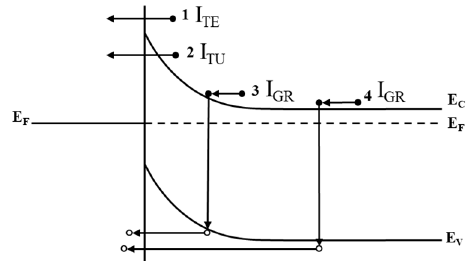
Figure 2. Transport processes under 0 bias. The processes number 1–number 4 are thermionic emission (1 I TE ), tunneling current (2 I TU ), generation-recombination current (3 I GR ) in space charge region, and hole injection from the metal to the semiconductor (equivalent to generation-recombination current in neutral region, 4 I GR ). (E F is fermi level, E C is Conduction band level and E V is Valence band level.)